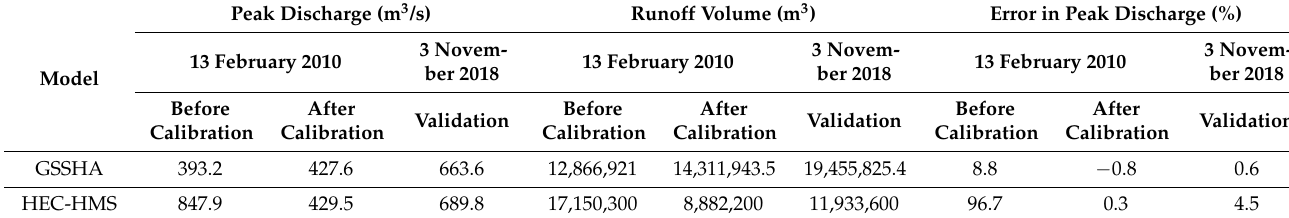
Table 2. Comparison between GSSHA and HEC-HMS simulation results.